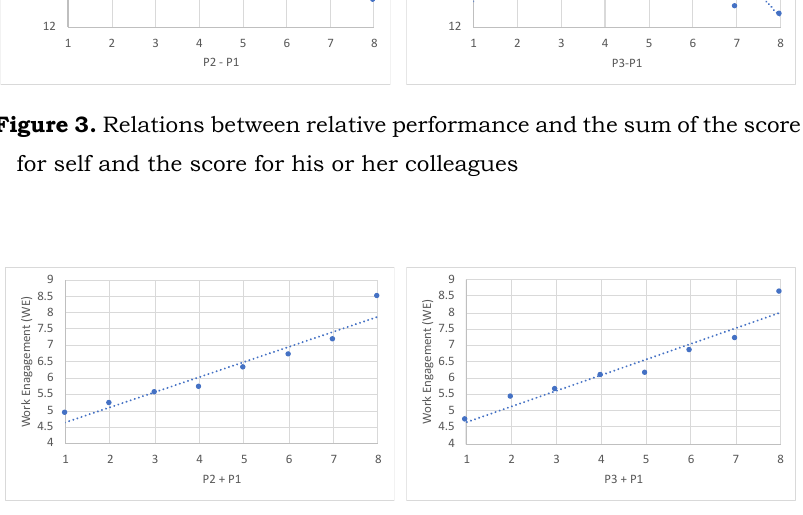
Figure 4. Relations between work enagagement and the sum of the score for self and the score for his or her